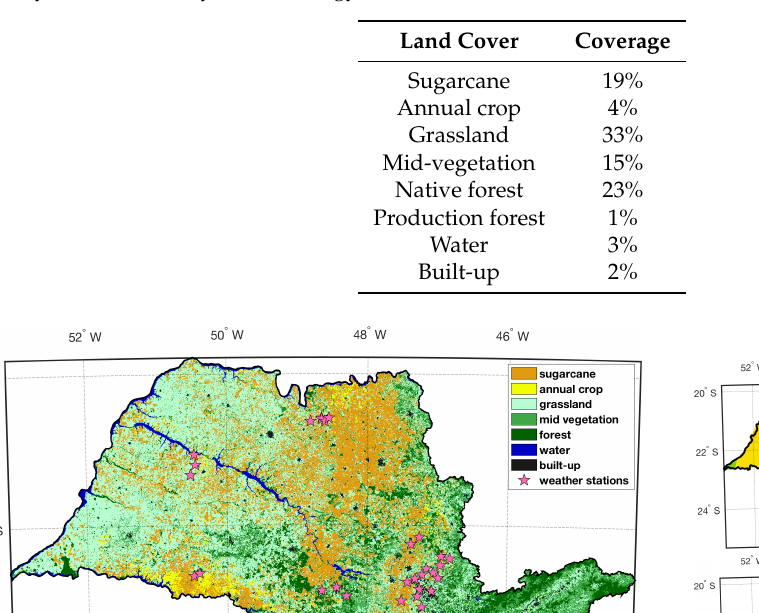
Table 1. Coverage of land cover types in São Paulo state based on the 2015 classification map produced by Delft University of Technology (TU Delft) [19,20].